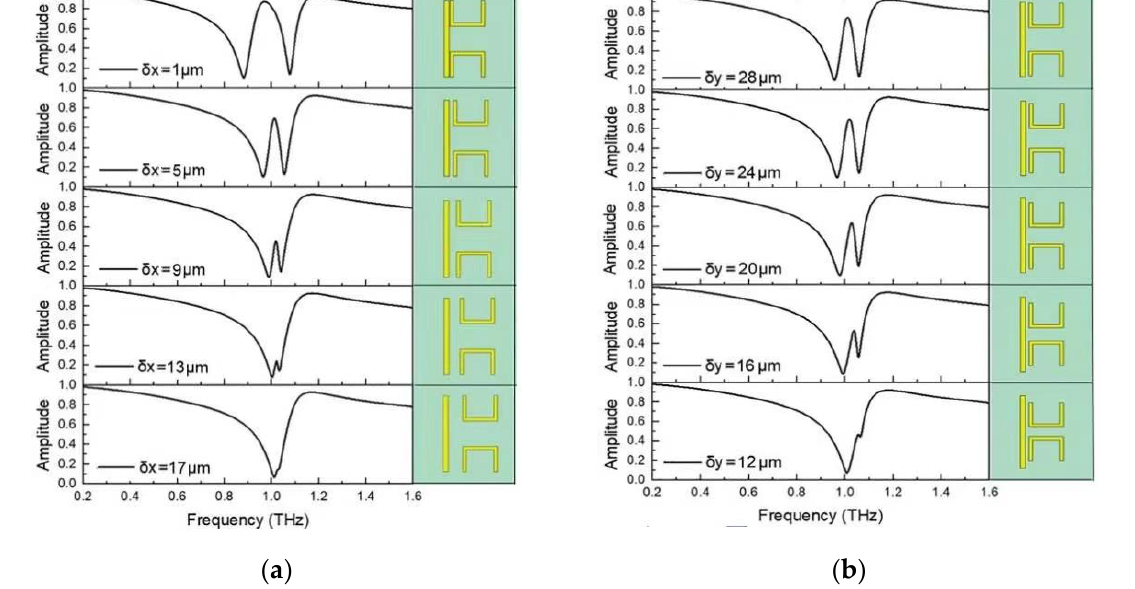
Figure 4. The influence of structural parameters on transmission characteristics. ( a ) The transmission spectra at various coupling distances between CW and USRs, as the δ x increases, the two resonance troughs of LSP and LC decrease and get closer, with the transparent window blue-shifted; ( b ) The transmission spectra at various coupling distances between USR pairs, as the δ y decreases, the LC resonance trough gradually disappears, while the transparent window also disappears.